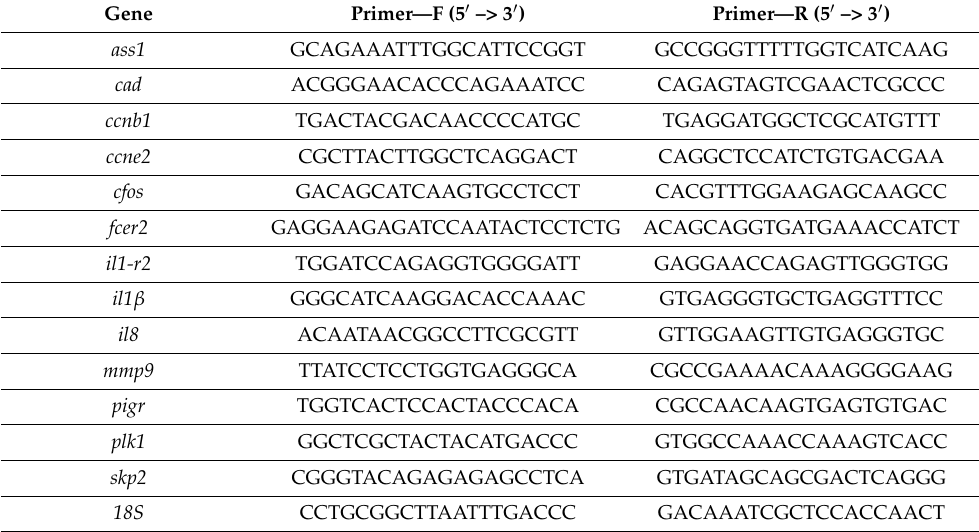
Table 2. qPCR primers used in the